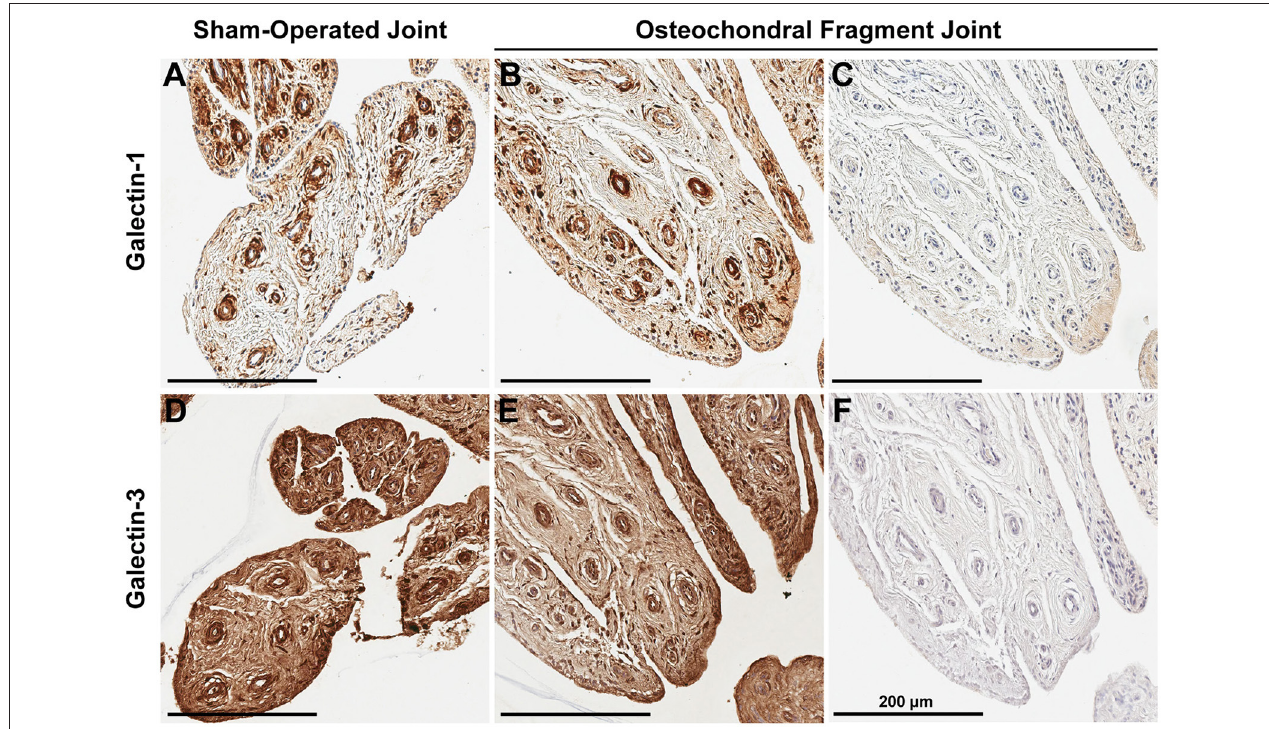
FIGURE 4 | Synovial membrane galectin-1 and galectin-3 immunostaining reveals constitutive galectin expression in both sham-operated (A,D) and osteochondral fragment joints (B,E) from a representative horse 70 days post-injury. Galectin-1 and-3 staining is most prominent in perivascular regions. No differences were observed in galectin-1 or-3 staining between sham-operated and osteochondral fragment joints. Primary antibodies were omitted in (C,F) , revealing absence of antigen-independent staining. Scale bar: 200 µ m.